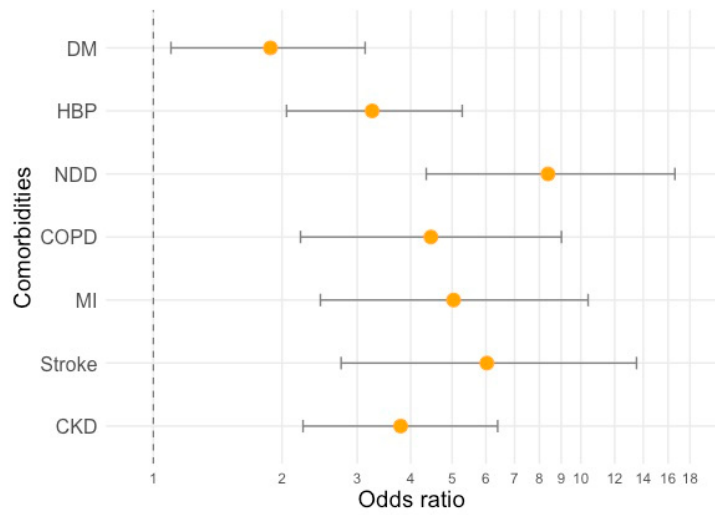
Figure 1. Odds ratios (yellow dots) and 95% confidence intervals for the risk of death during hospitalization, according to existing comorbidities. DM—diabetes mellitus, HBP—high blood pressure, NDD—neurodegenerative diseases, COPD—chronic obstructive pulmonary disease, MI—previous myocardial infarction, and CKD—chronic kidney disease. Table 4. Symptoms at admission and clinical outcomes by the number of liver abnormalities. Data represent number of cases (%) for the categorical variables and mean (SD) or mean (IQR) for the continuous parametric and non-parametric variables, respectively. p : p -value for the comparison of groups; chi 2 for categorical variables and ANOVA or Kruskal-Wallis for continuous parametric and non-parametric variables, respectively; and n —number of available cases for each